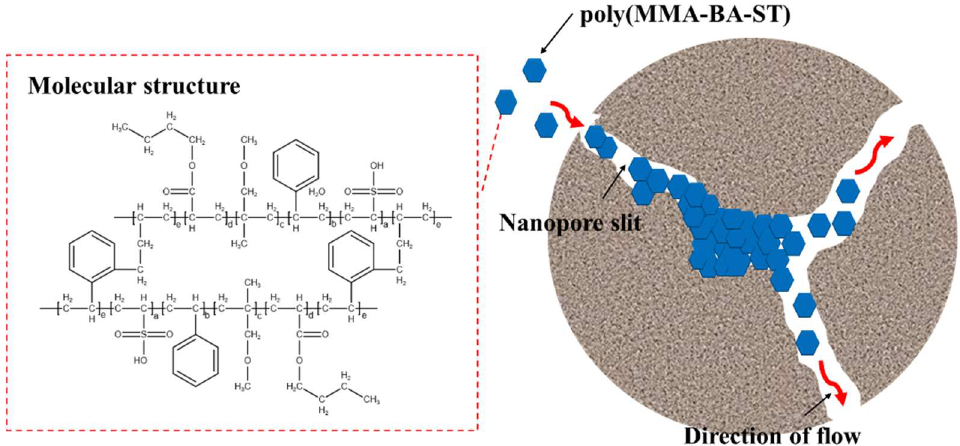
Figure 11. Diagram of poly (VS-St-BMA-BA) plugging mechanism.